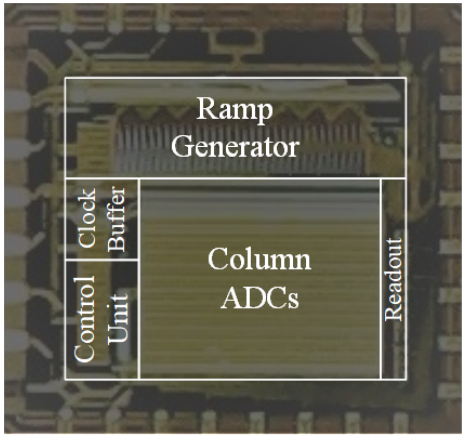
Figure 22. Microphotograph of the ADC chip.